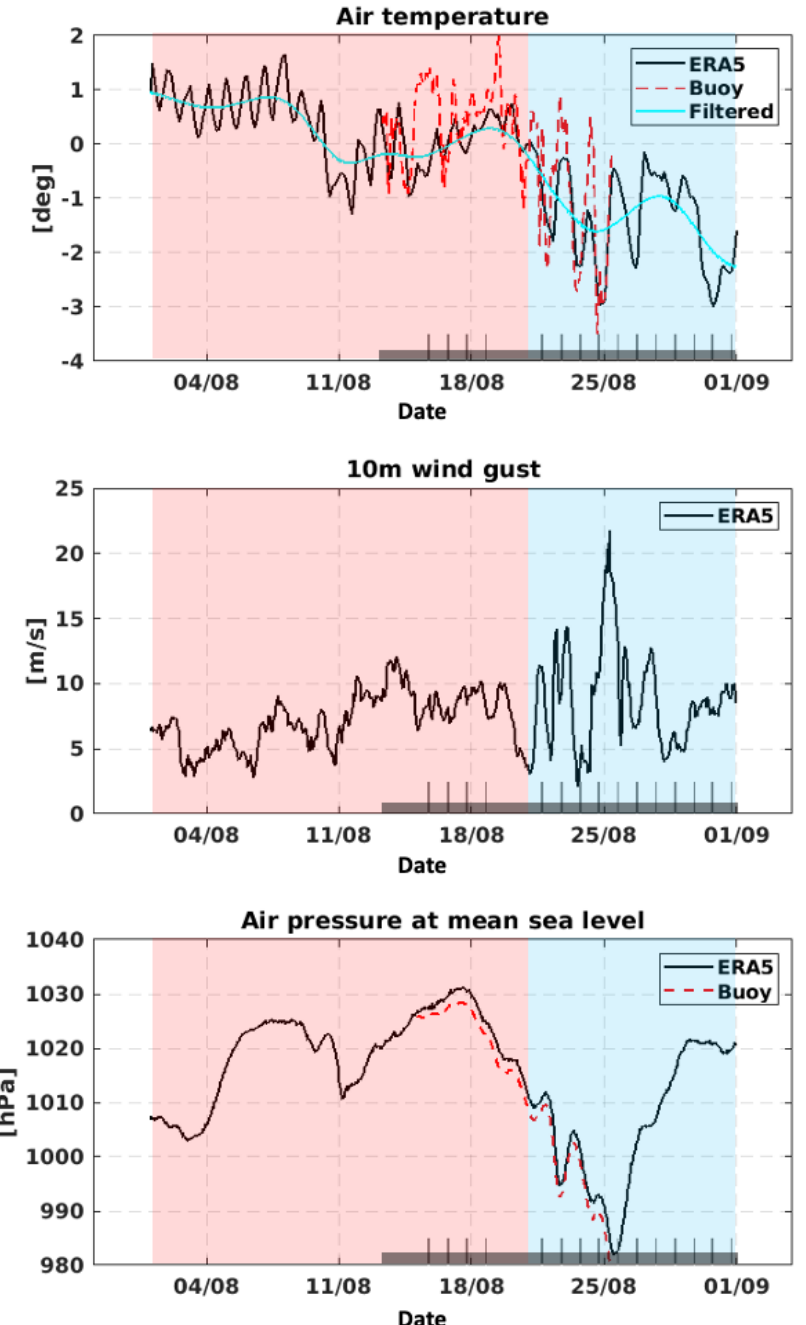
Figure 6. Air temperature, wind gust, and air pressure at mean sea level around the research period are extracted from ERA5 reanalysis data for comparison with the backscattering coefficients. The dark bar at the bottom refers to the research period of which Sentinel-1 data are used and black vertical lines indicate the acquisition times of Sentinel-1 data. In situ measurement by the thermometer and barometer on a buoy are denoted by a dashed red line. The air temperature is smoothed by a Gaussian filter with a width of 24-h, denoted by a cyan solid line. The estimated end of melt and onset of freeze-up based on the air temperature was around August 20, 2019, which are expressed by red and blue backgrounds, respectively.